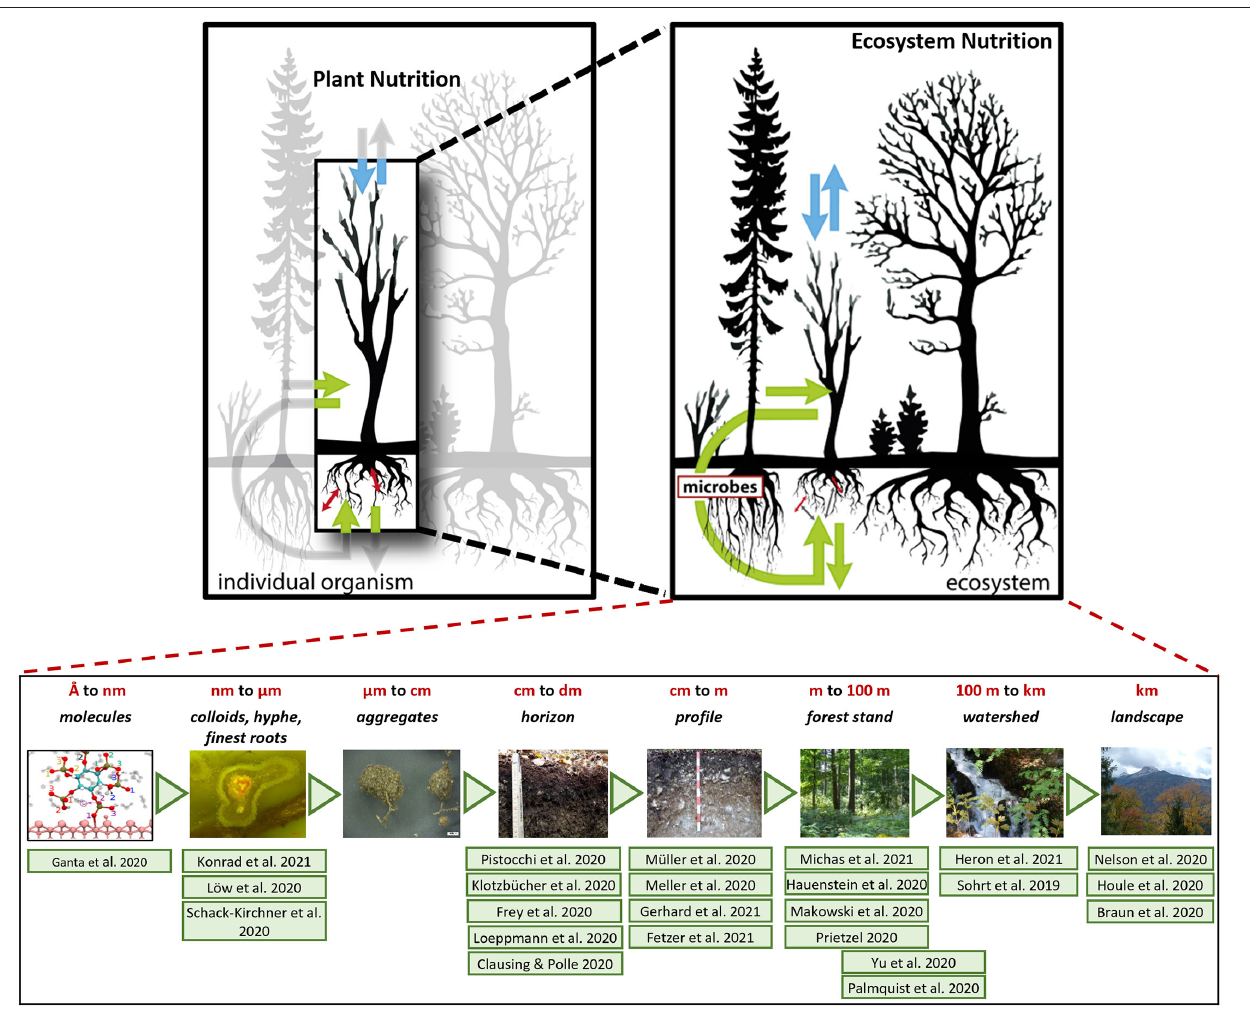
FIGURE 1 | In contrast to plant nutrition, which focuses on individual target plants, ecosystem nutrition covers all ecosystem compartments and their interactions (Top) . The different articles within the Research Topic Changes in Forest Ecosystem Nutrition address manifold compartments and interactions on a wide range of spatial scales (Bottom)